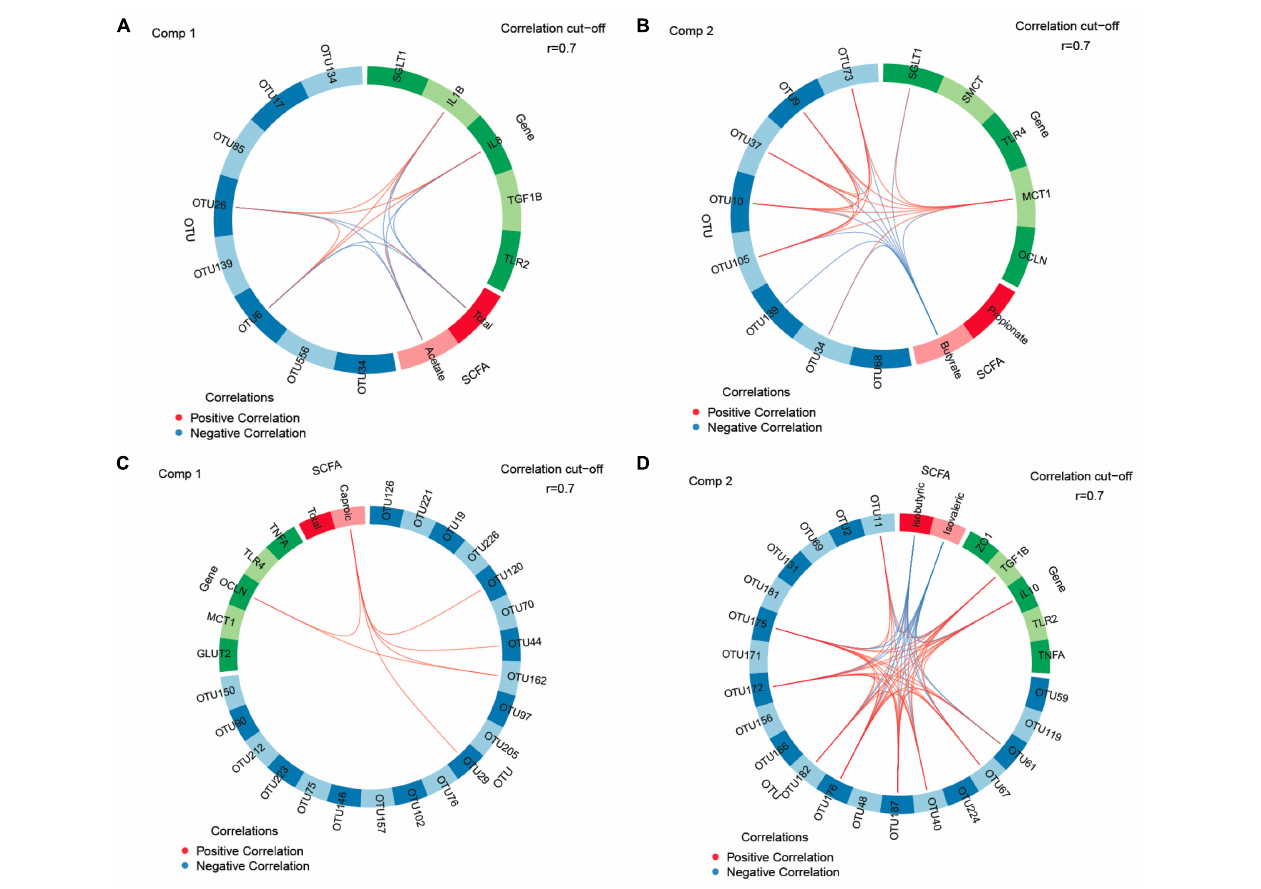
FIGURE 1 | Circos plots of horizontal sparse partial least squares-discriminant analysis displaying correlations between the identified best discriminant operational taxonomic units (OTUs), short-chain fatty acids (SCFA, n = 5) and expression levels of target genes for component 1 and component 2 in the jejunum and ceca. Correlations for component 1 (comp) 1 (A) and 2 (B) in jejunum (OTUs, n = 8; SCFA, n = 2; genes, n = 5). Correlations for comp 1 (C) and 2 (D) in ceca (OTUs, n = 20; SCFA, n = 2; genes, n = 5). Positive and negative correlations ( | r | > 0.7) are displayed by red and blue links, respectively. Relative abundance of bacterial OTUs > 0.01% of all reads. GLUT2 , glucose transporter 2; IL , interleukin; MCT1 , monocarboxylate transporter 1; OCLN , occludin; SGLT1 , sodium-dependent glucose transporter 1; SMCT , sodium/monocarboxylate transporter; TGF1B , transforming growth factor beta-1; TLR , toll-like receptor; TNFA , tumor-necrosis factor alpha; ZO1 , zonula occludens. The taxonomic identification of the most influential OTUs can be found in Supplementary Table S8